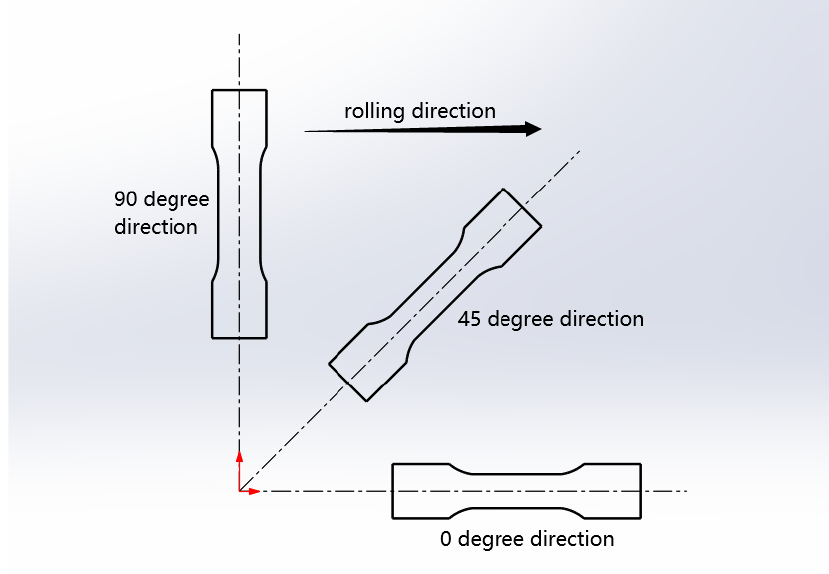
Figure 5. Truncation direction of experimental specimen.